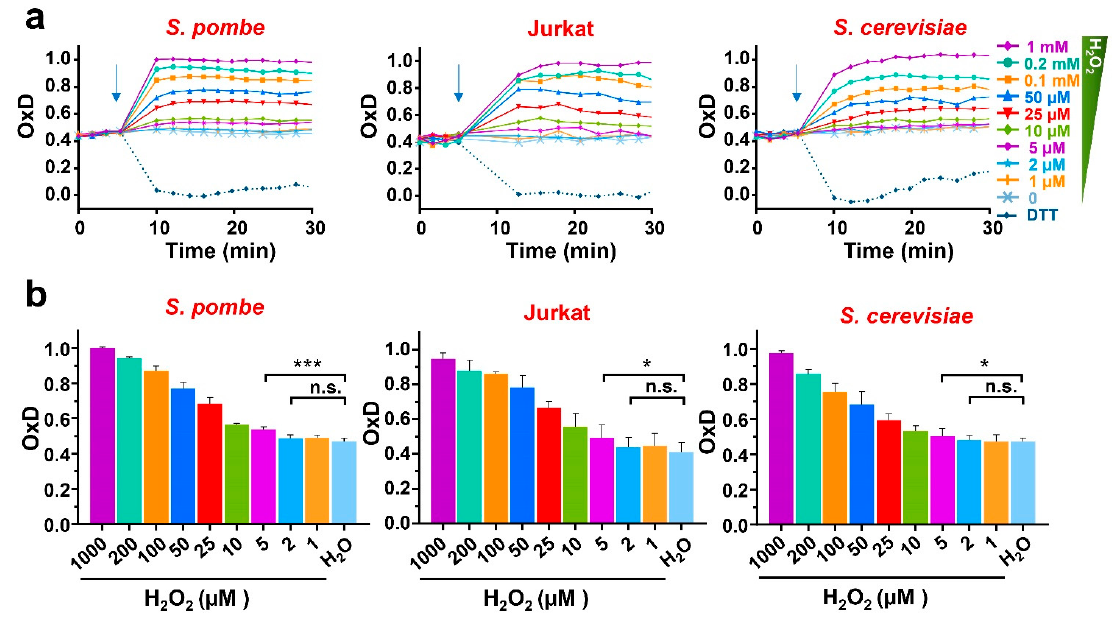
Figure 2. H 2 O 2 -dependent oxidation of roGFP2-Tpx1.C169S expressed in S. pombe , Jurkat T cells, and S. cerevisiae . Wild-type of S. pombe (HM123), S. cerevisiae (BY4741), or Jurkat T cells, transformed with p407.C169S, p791, or p797 to express roGFP2-Tpx1.C169S, were grown in their own media (MM-, SD-, or RPMI 1640-supplemented), centrifuged and resuspended in MM (both yeasts) or ISO (Jurkat) for a final OD 600 of 1 (both yeasts) or 0.5 (Jurkat cells). Then, 190 µL of these cell suspensions were plated in 96-well imaging plates, and incubation and fluorescence recording were initiated at 37 °C with 100 rpm shaking. After 4 cycles, the indicated treatments of DTT or H 2 O 2 were applied (indicated with arrows). The degree of probe oxidation, or OxD (amount of probe oxidation per 1), is indicated over time. ( b ) Bar graphs represent the average of 3 OxD values from the 12 to 17 min time points for each treatment and cell type represented in Figure 2a. Statistical significance was calculated between the indicated samples with a ratio paired Student’s t-test with p -values of 0.05 (*) and 0.001 (***); n.s., non-significant. For each strain, average data from four biological replicates are shown, with error bars (S.D.) of ( a ) displayed in Figure